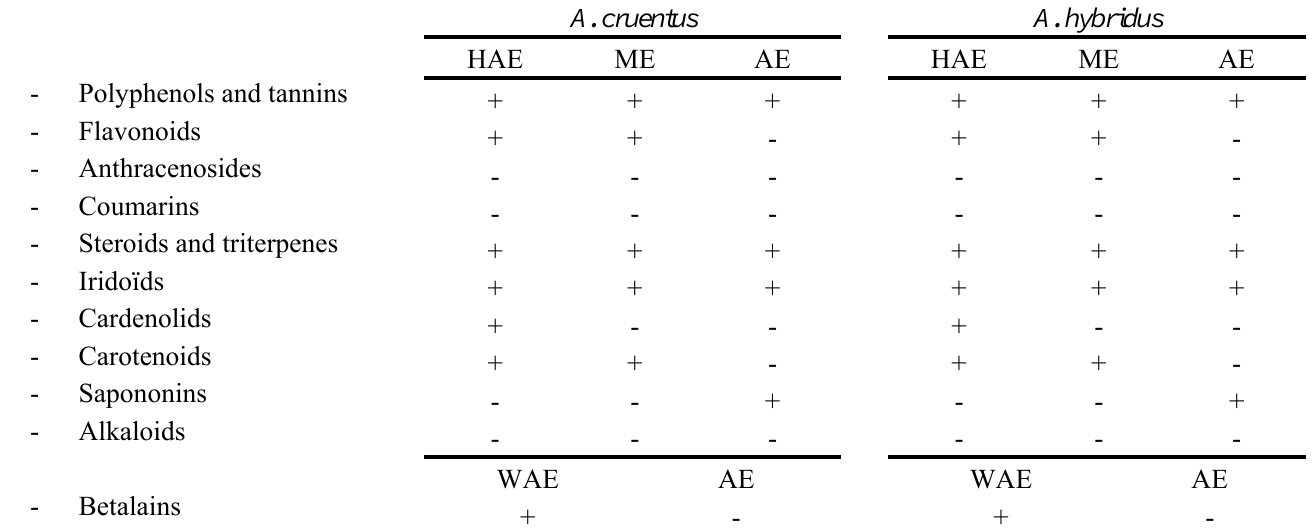
Table 2. Phytochemical composition of A. cruentus and A. hybridus